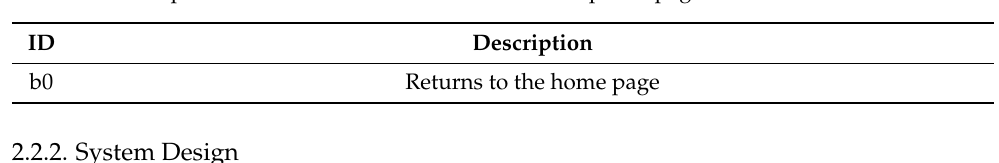
Table 11. Description of the button found on the “test complete” page.